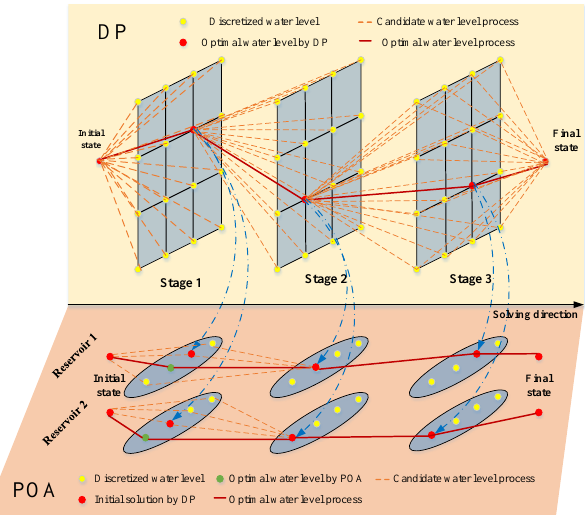
Figure 2. The skeleton of the dynamic programming combined with progressive optimality algorithm. (DP-POA)